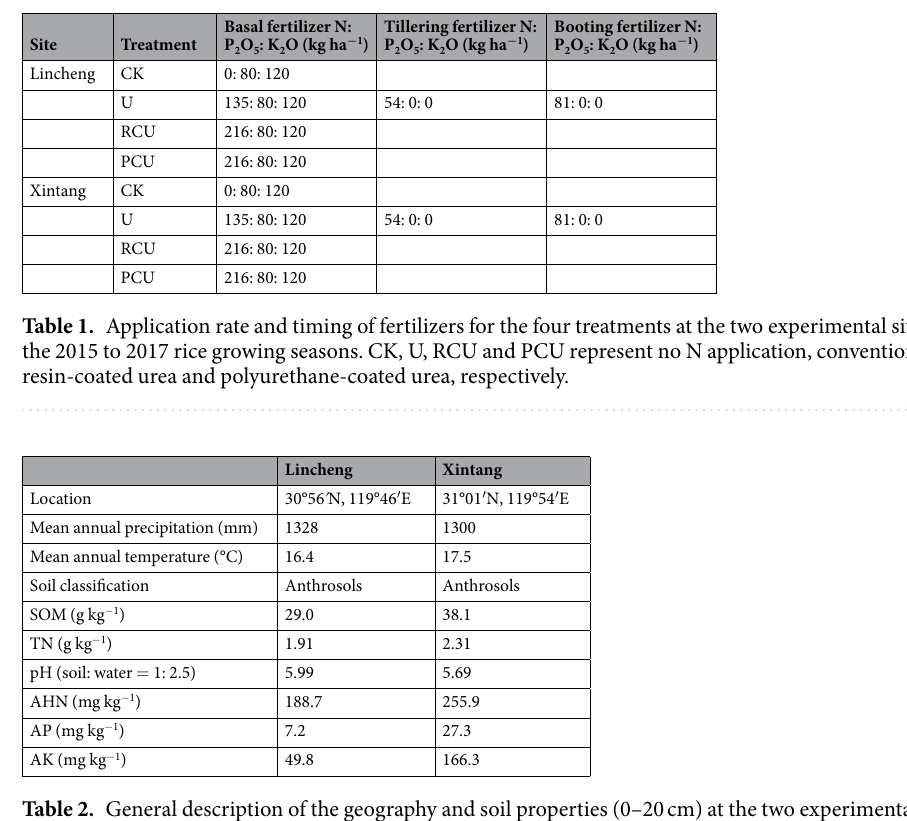
Table 2. General description of the geography and soil properties (0–20 cm) at the two experimental sites. SOM, TN, AHN, AP and AK represent soil organic matter, total nitrogen, alkaline hydrolyzable nitrogen, available phosphorus and available potassium,